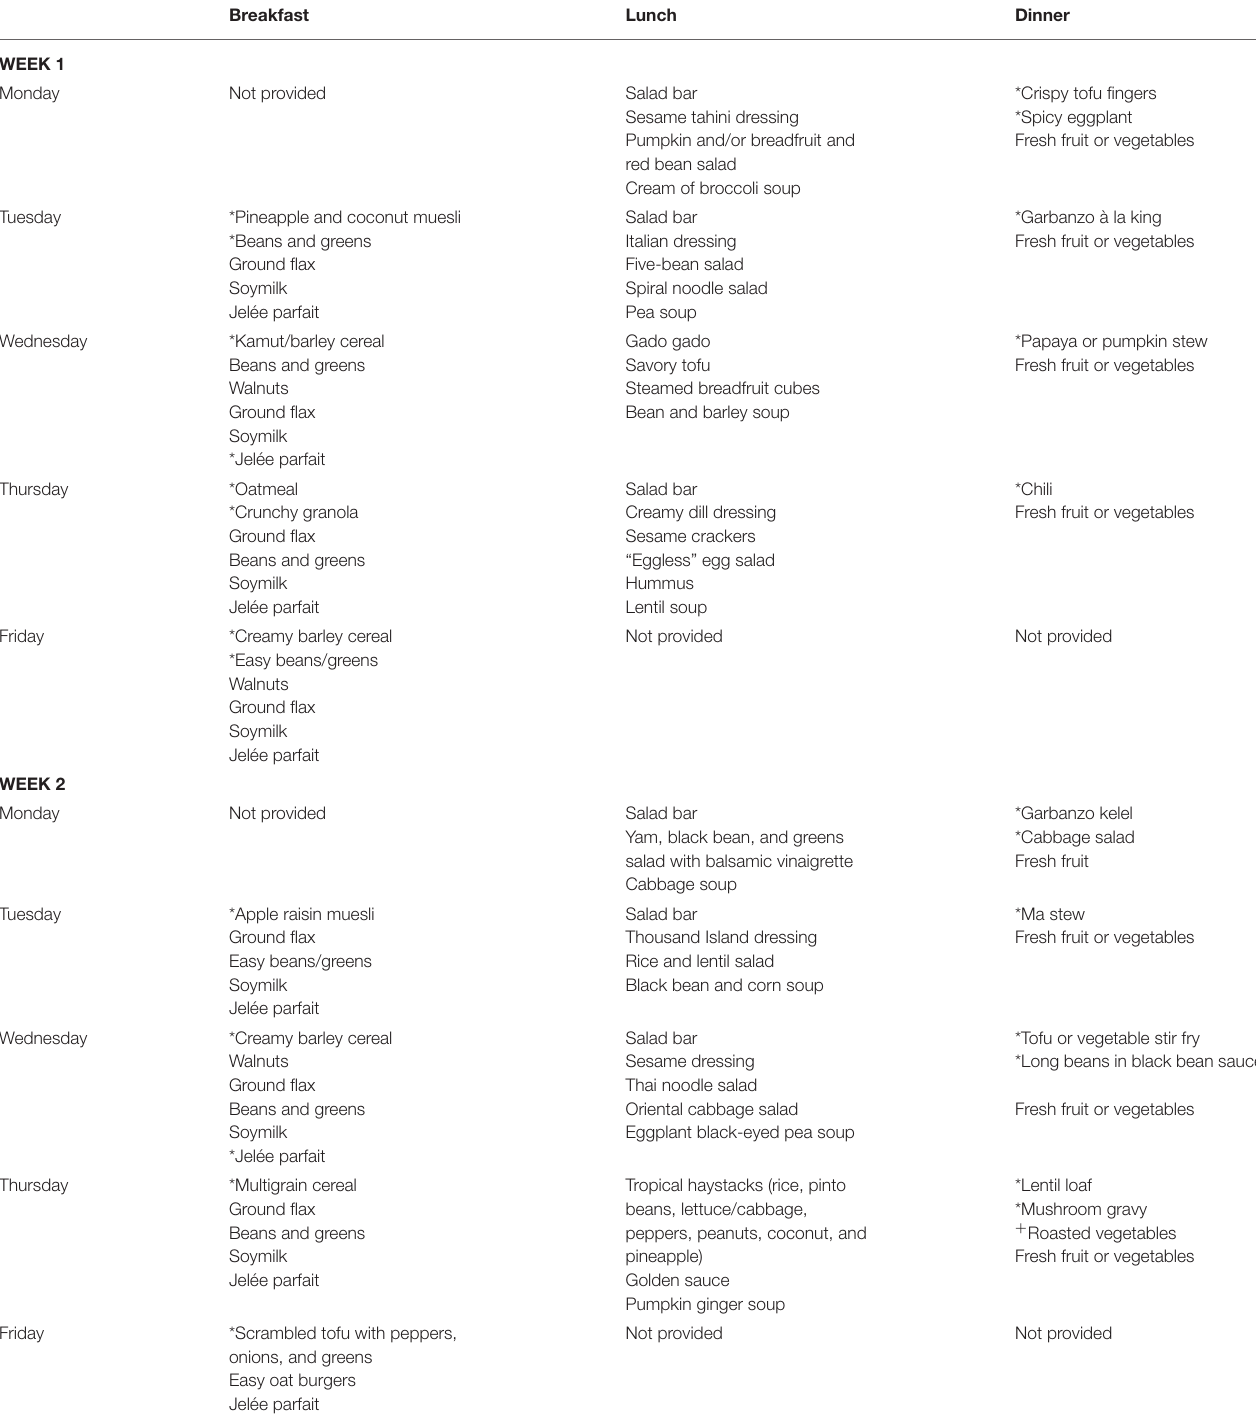
TABLE 2 | Study menus for weeks